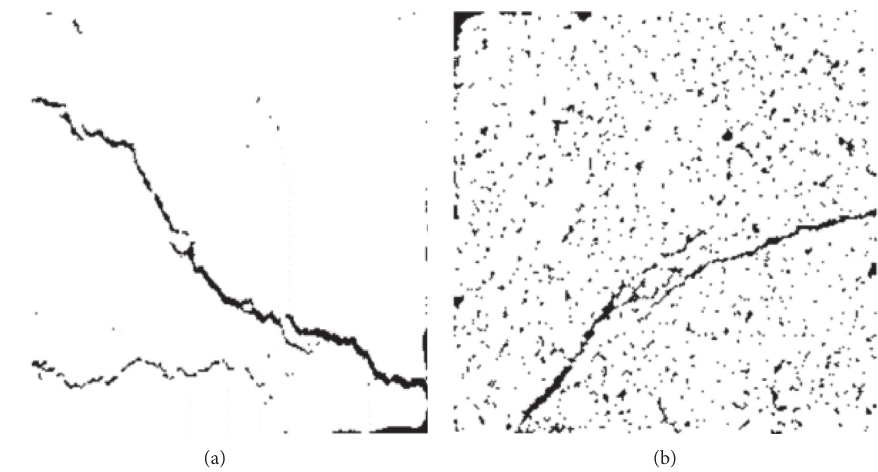
Figure 22: Percolation results using the mean-padding technique: (a) crack 1; (b) crack 2.